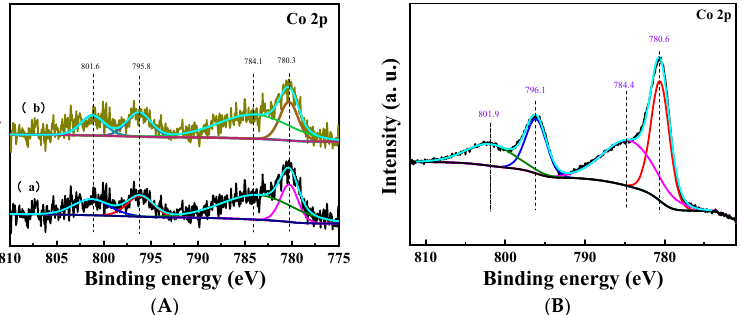
Figure 6. Co 2p XP spectra of the fresh (a) and the spent (b) SiO 2 ‐ APTES ‐ EASA ‐ Co catalysts ( A ) in comparison with the Co 2p XP spectrum in Co(acac) 2 ( B ). comparison with the Co 2p XP spectrum in Co(acac) 2 ( B